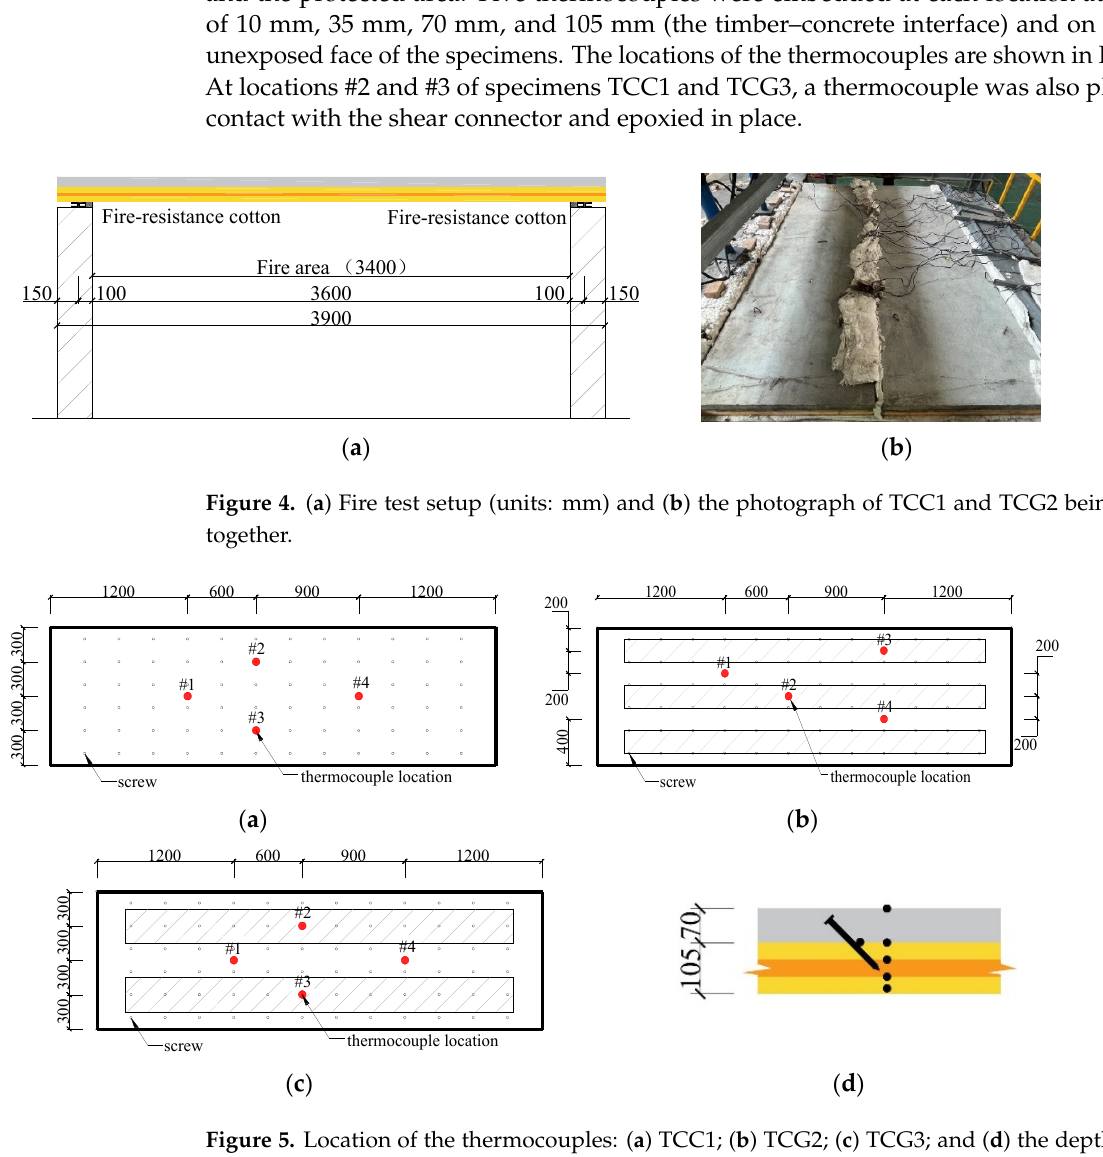
Figure 3. ( a ) Schematics of push-out tests (units: mm) and ( b ) the photograph of the push-out test system (Reproduced with permission from Ref. [8]. Copyright 2022 Elsevier.).